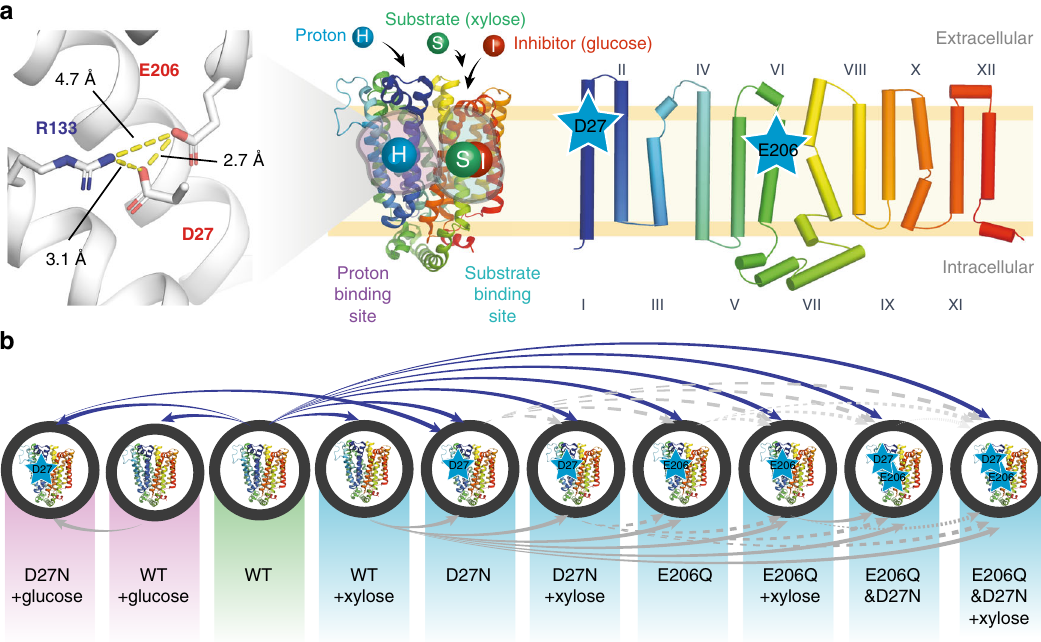
Fig. 1 Structure of XylE and proposed experiment design. a Topological and 3D structure of XylE (PDB: 4GBY) 17 . Three charged residues of interest in the proton binding site (D27, R133 and E206) are shown with their intra-residue distances. b Twenty-eight combinations of eight different protein states of XylE WT and three mutants (D27N, E206Q and E206Q&D27N) in the presence or absence of a substrate (xylose) and four combinations of XylE WT and mutant D27N in the presence or absence of an inhibitor (glucose) were studied in this work. All structural representations were generated using PyMol. Mutated residues are indicated by a star. Tables reporting experimental details for each Δ HDX-MS experiment are available as Supplementary Data File